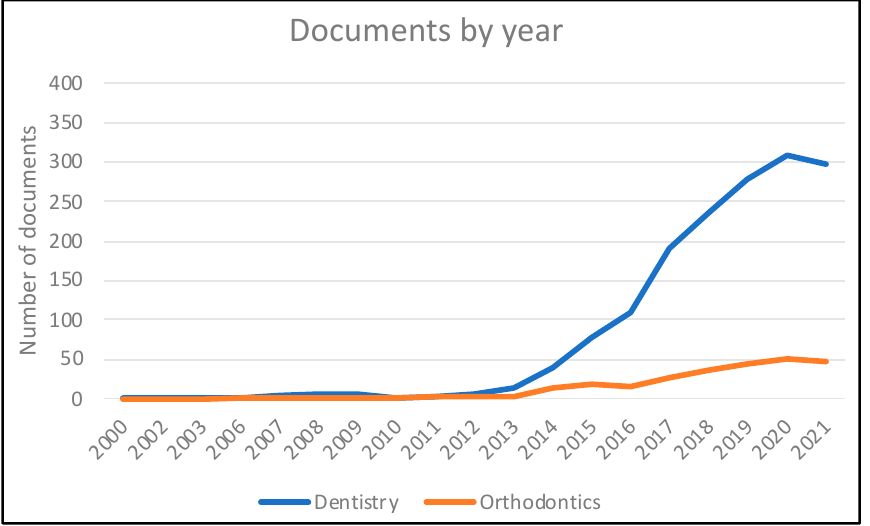
Figure 1. Bibliometric analysis with Scopus and PubMed Database considering years from 2003 to 2021 (data for the latter year are ongoing).